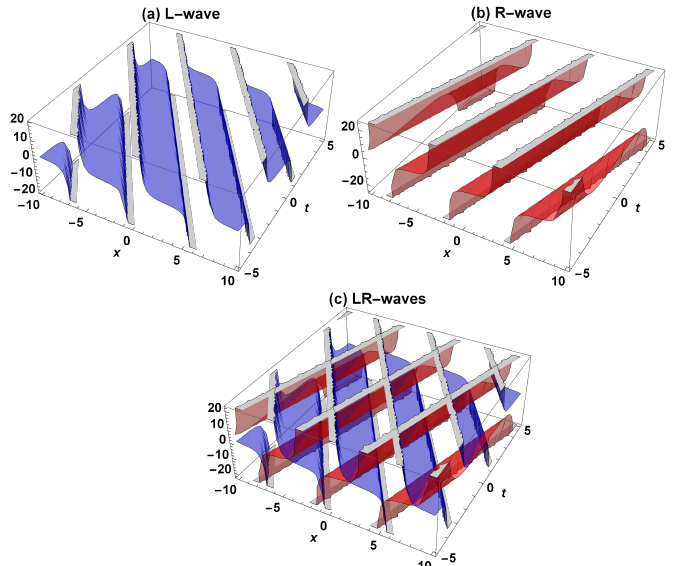
Figure 4. Propagation of the binary waves of θ 3 ( x , y , t ) in (21) Known as ( a ) L-wave. ( b ) R-wave. ( c )